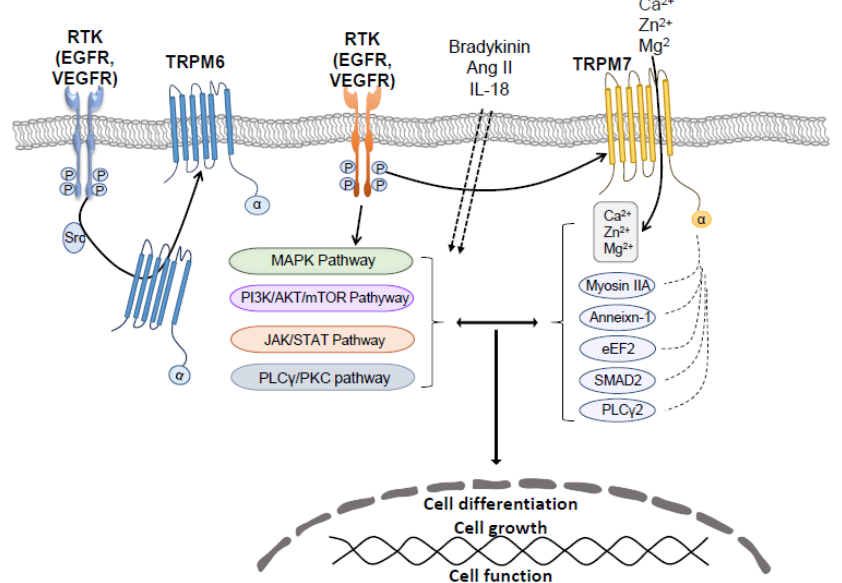
Figure 6. Cross-talk between Receptor Tyrosine Kinases (RTK) downstream signaling and TRPM7. TRPM7 has the dual properties of acting as an ion channel mainly permeable to Zn 2 + , Mg 2 + and Ca 2 + , and as a cytoplasmic kinase, which phosphorylates annexin-1, myosin IIA heavy chain, eEF2, SMAD2, and PLC γ 2. Through either its channel or kinase, TRPM7 participates in RTK downstream signaling pathways. On the other hand, ligand induced activation of RTKs, such as EGFR, regulates the activity of TRPM7 or TRPM6. Signaling by bradykinin, Ang II, and IL-18 also influence TRPM7 activity. Dotted arrows indicate activation through the cell membrane; Solid arrows indicate activation of target protein; T indicate inhibition.